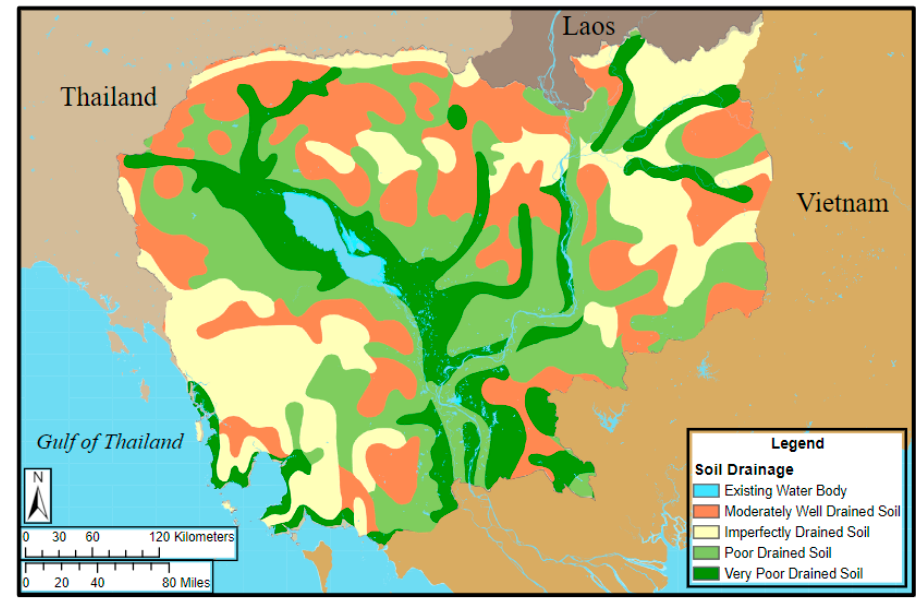
Figure 1. Soil drainage map of Cambodia. Adapted from FAO’s [30] Harmonized World Soil Database.